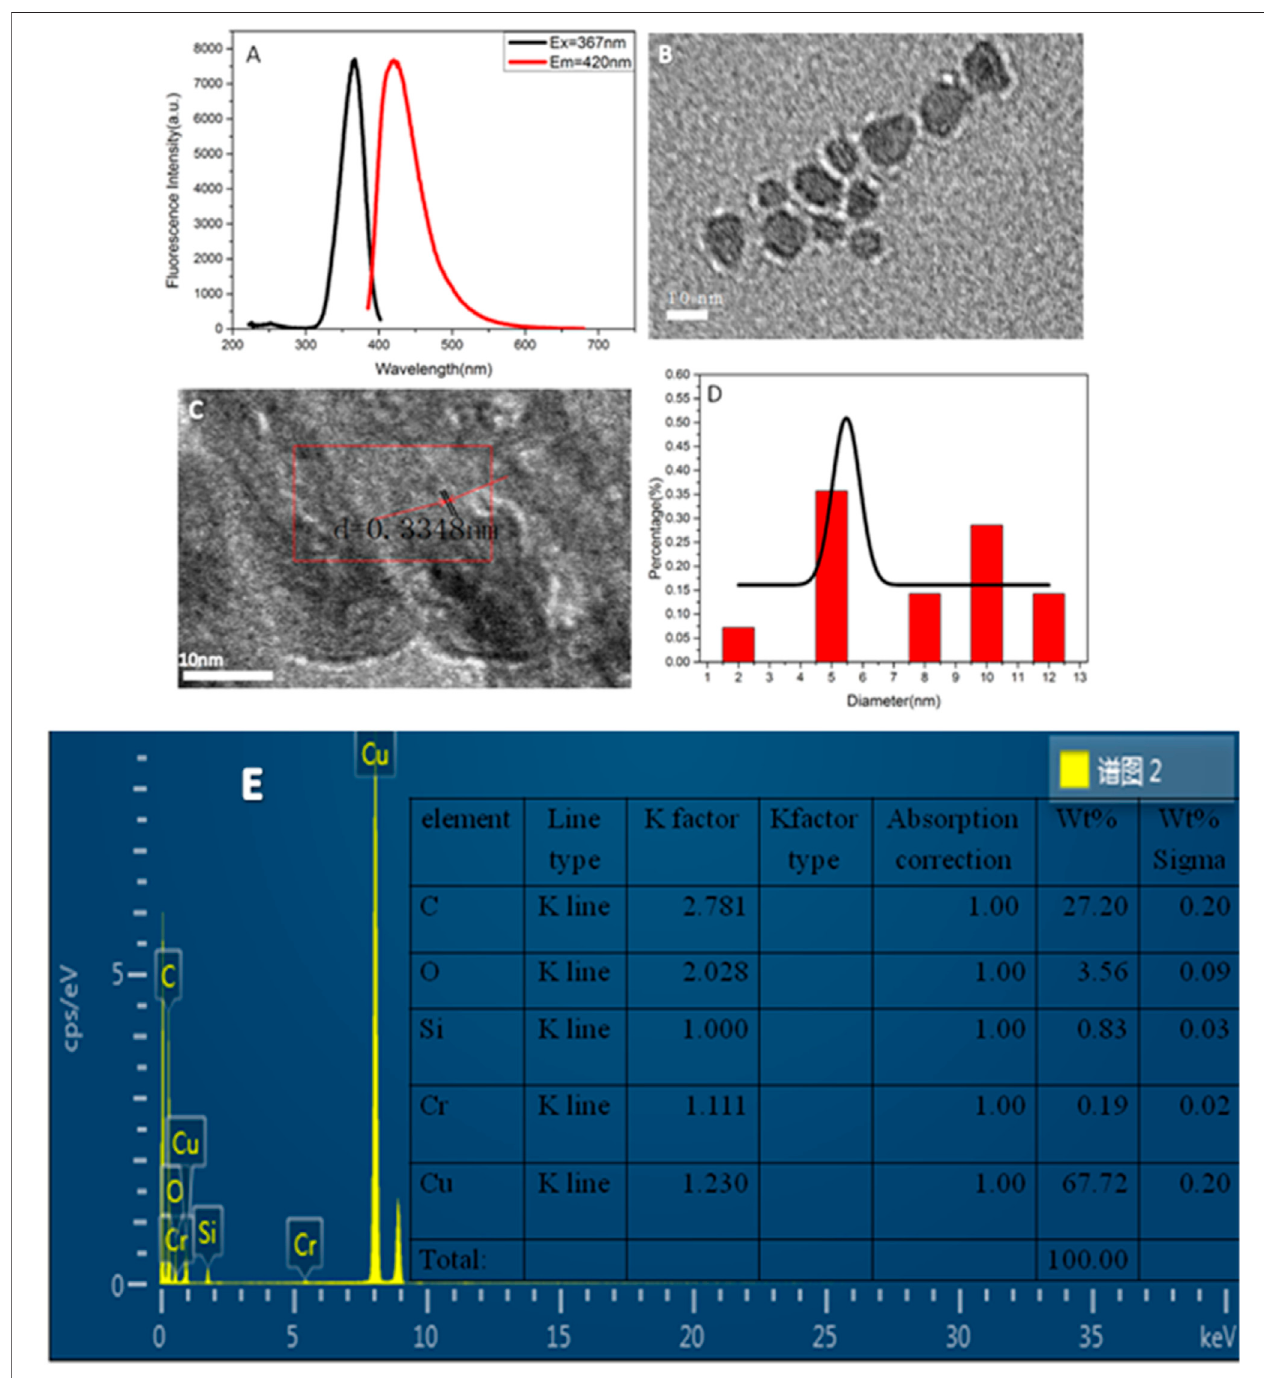
FIGURE 1 | (A) Fluorescence spectra of copper nanomaterials; (B) TEM image of copper nanomaterials; (C) HRTEM image of copper nanomaterials; (D) size distribution histogram of copper nanomaterials; (E) ED image of